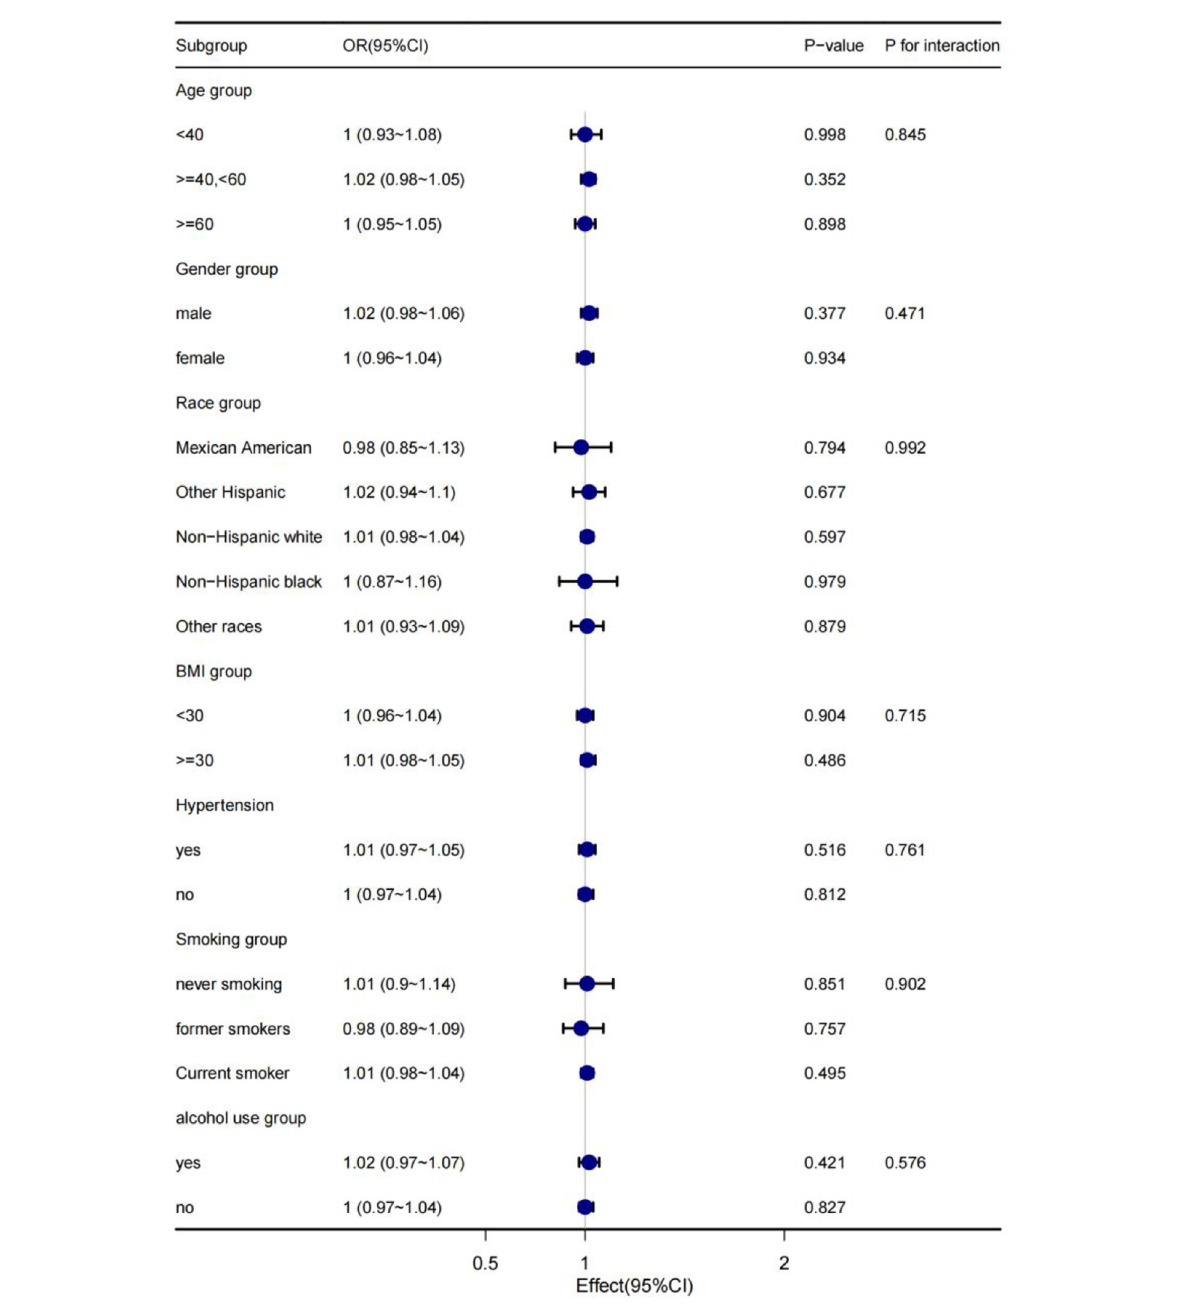
FIGURE5 The stratification logistics regression analysis of the associations of serum cadmium levels in high cadmium exposure with diabetes in different subgroups.